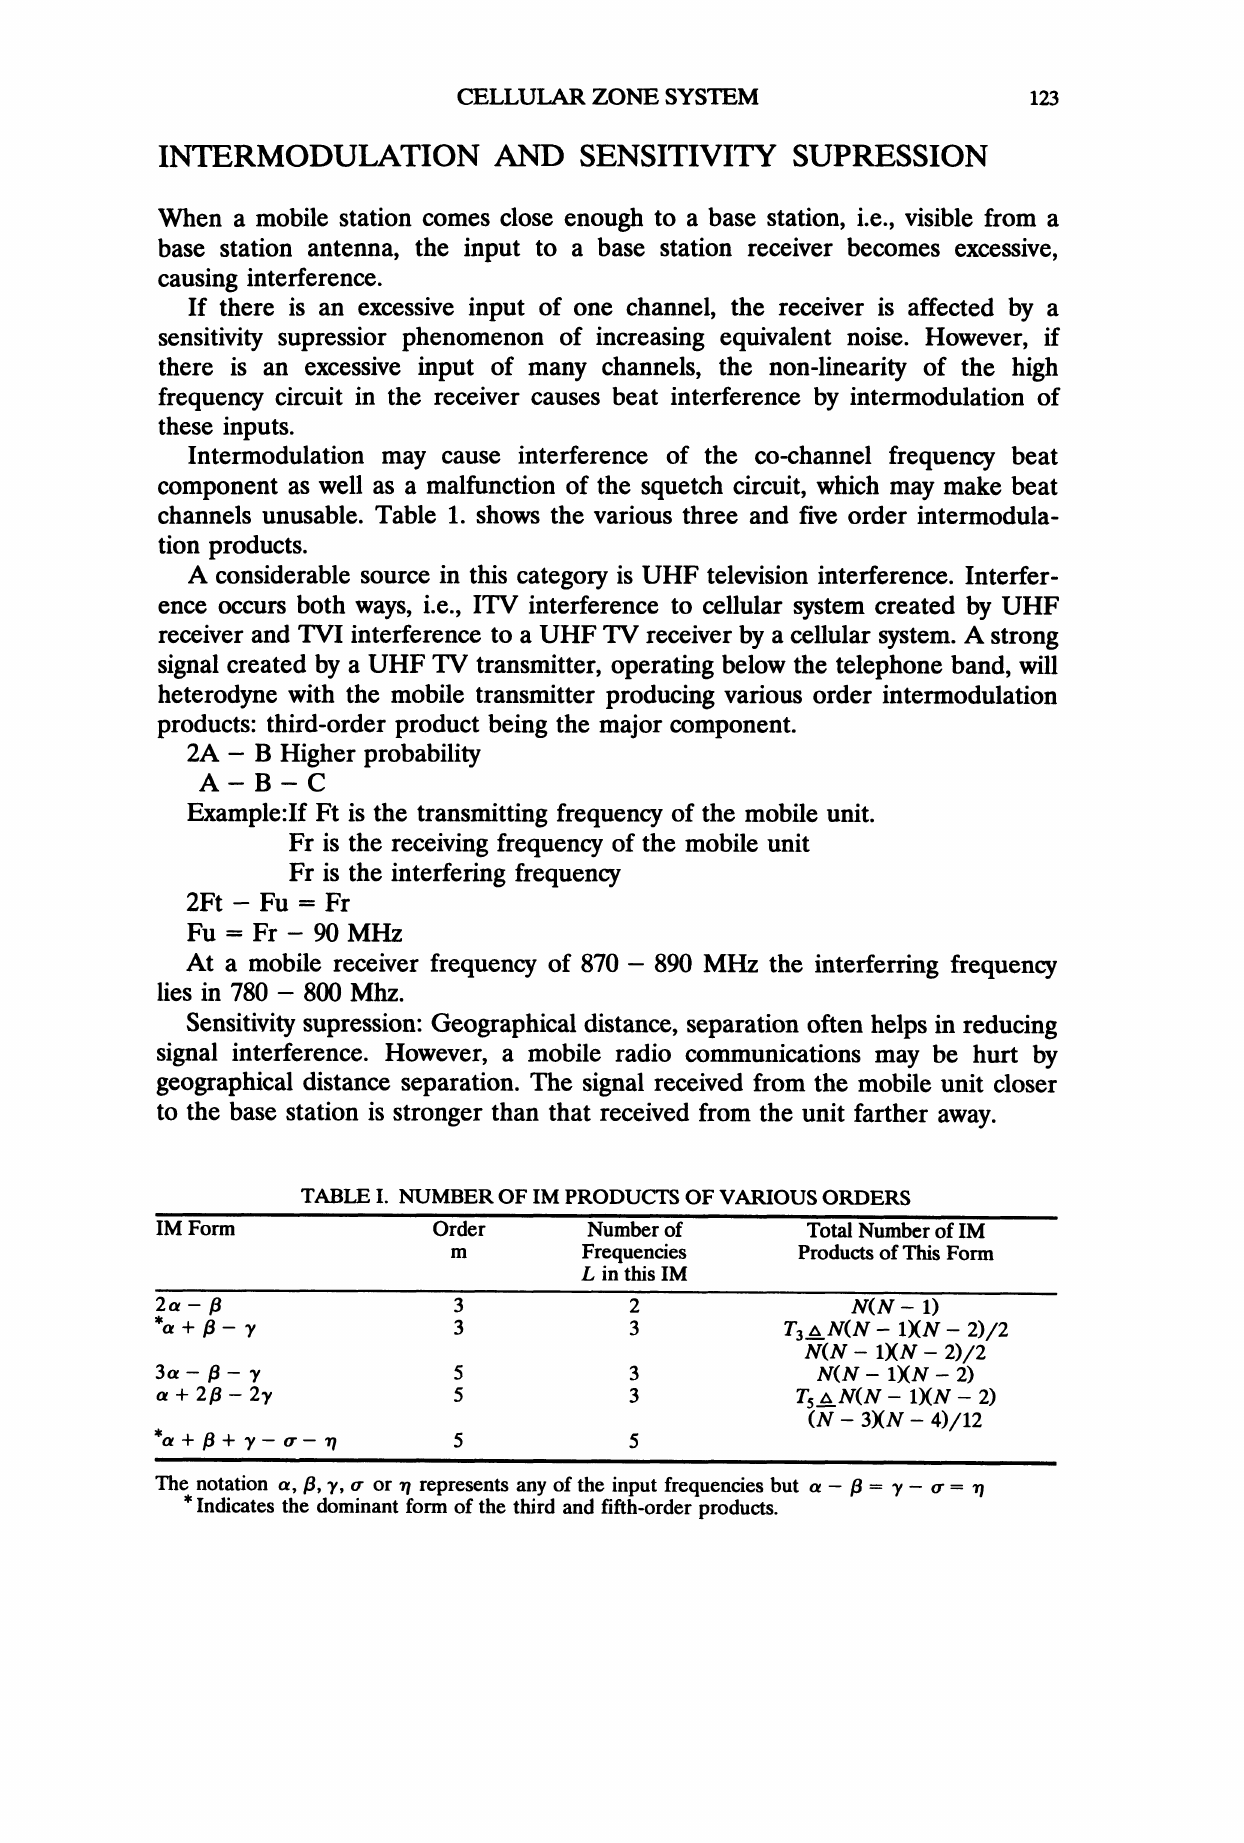
TABLE I. NUMBER OF IM PRODUCTS OF VARIOUS ORDERS